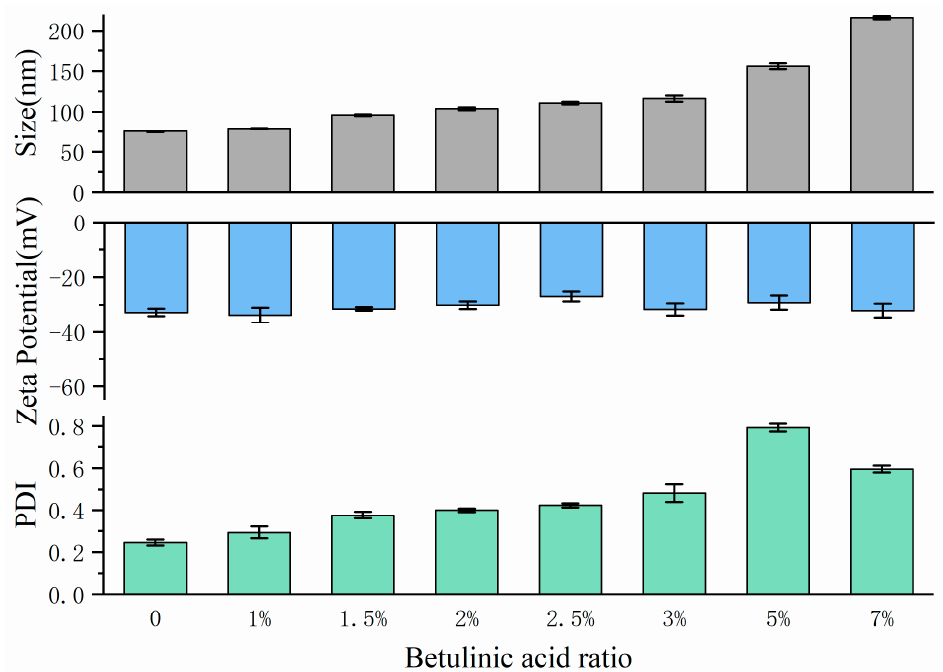
Figure 4. The e ff ect of adding BA on the size, PDI and zeta potential of liposomes. MEL-A ratio was set as 5% in this investigation, SPC:CHOL was determined as 3:1. Error bars represent standard deviations (SD) ( n = 3).